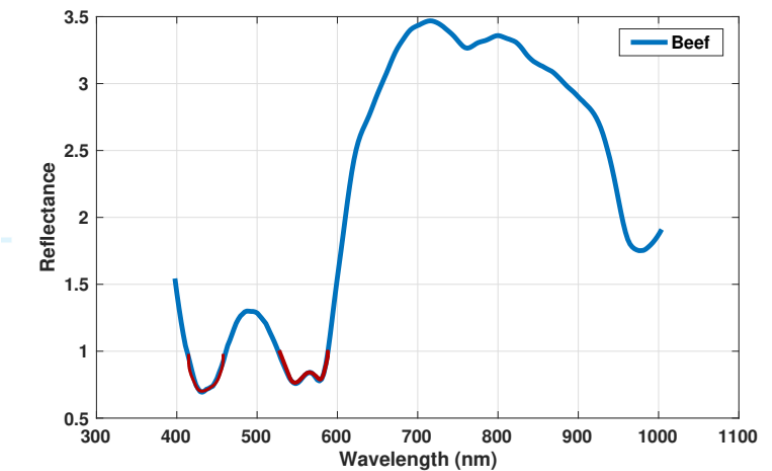
Figure 4. Spectral band reduction of minced meat spectrum; the red line represents the selected bands and blue line represents the Isos-bestic point scaling of the reflectance